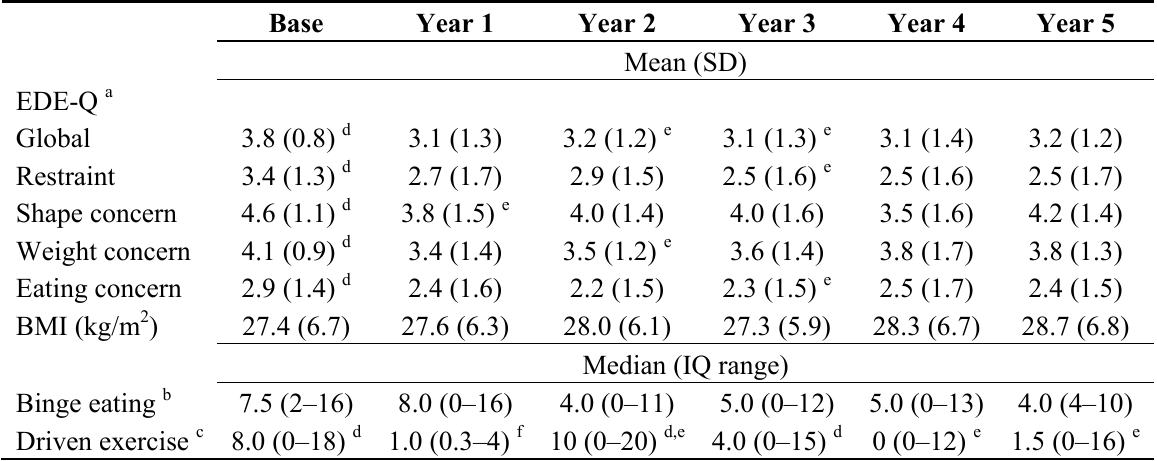
Table 2. Comparative eating disorder features over each of the 5-years for Cohort 1 ( n =